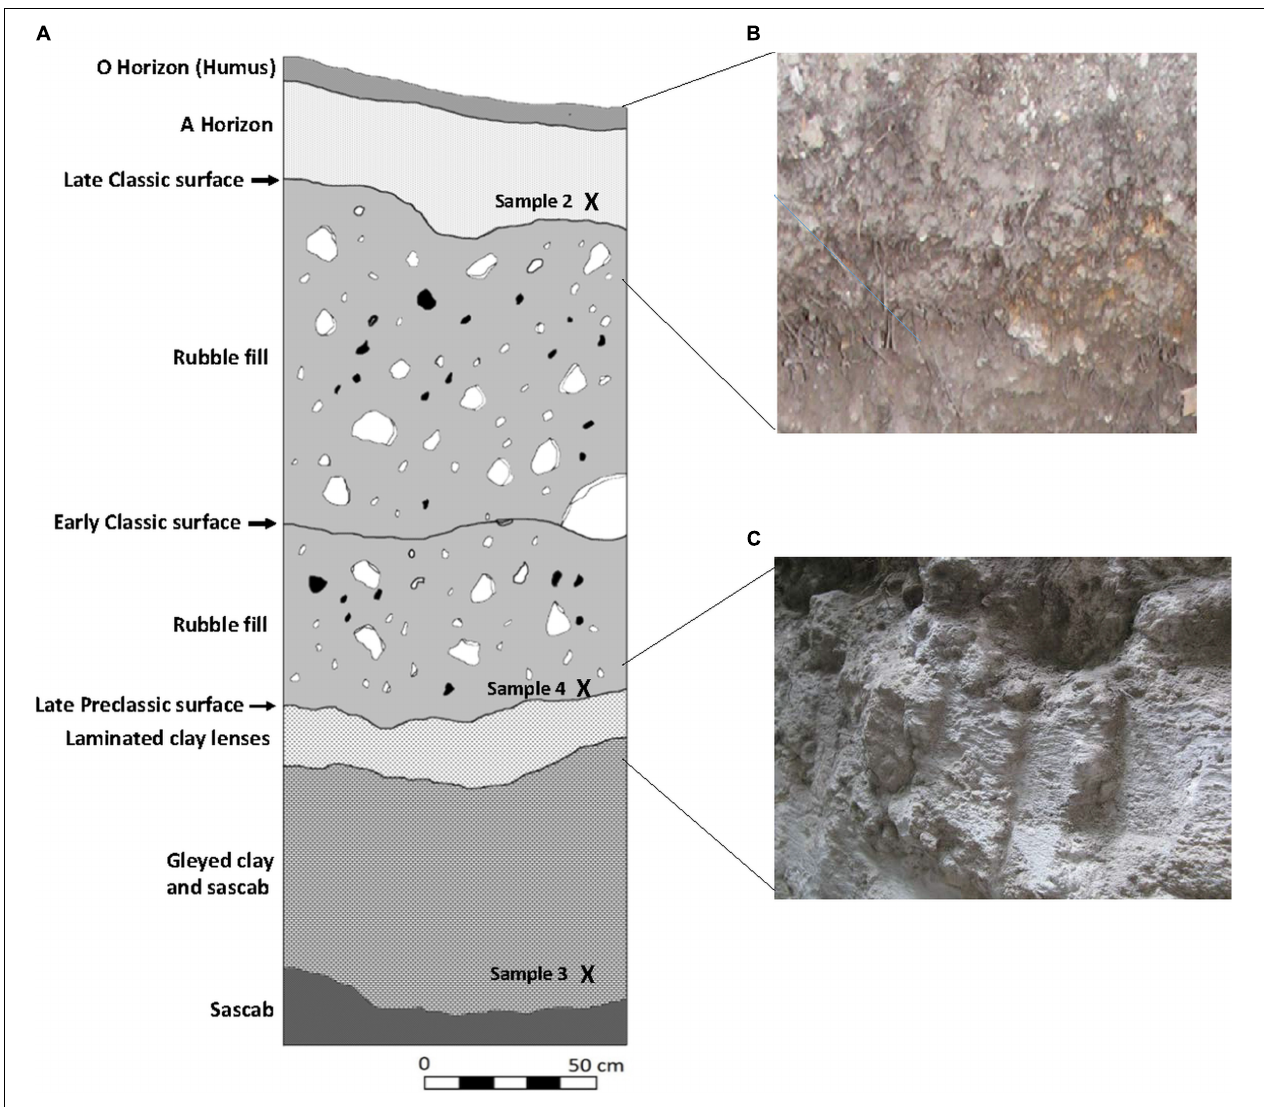
FIGURE 5 | Profile drawing and photograph of Operation 26ABC. The “X” marks the location where the eDNA samples were collected. (A) Drawing of the entire profile, (B) photograph of the (A) horizon and (C) is a photograph of the Late Preclassic surface.